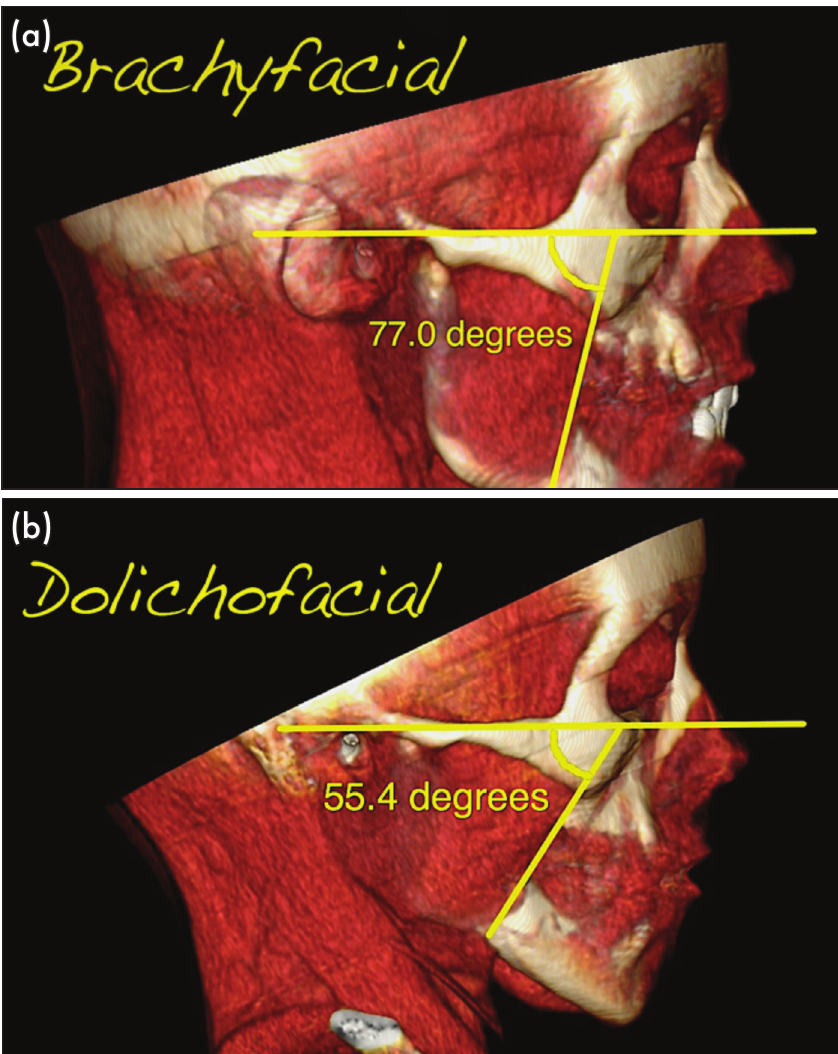
Figure 6. Extremes of underlying vertical facial pattern: (a) Brachyfacial: note angle between anterior border of masseter and Frankfort horizontal is 77.0 o ; (b) Dolichofacial: note angle between anterior border of masseter and Frankfort horizontal is 55.4 o